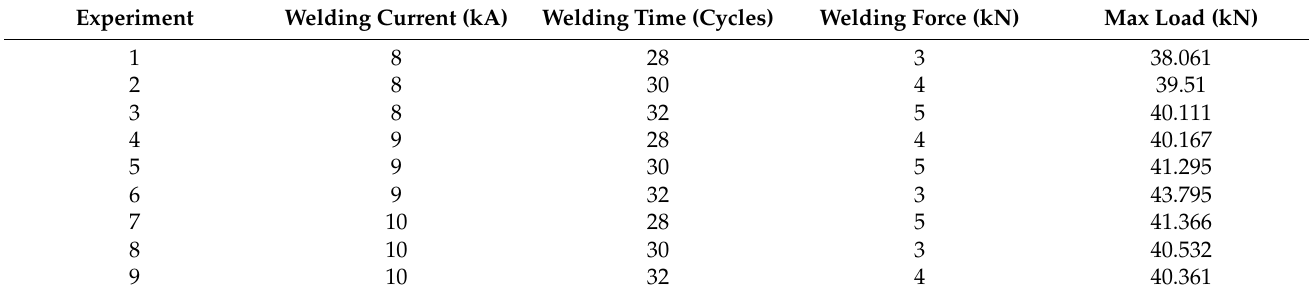
Table 3. Maximum load results of the tensile-shear